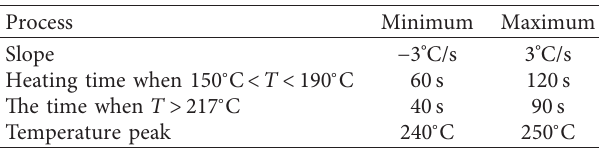
Figure 6: Results of numerical simulations: (a) temperature profiles and (b) relative errors. Table 2: Process